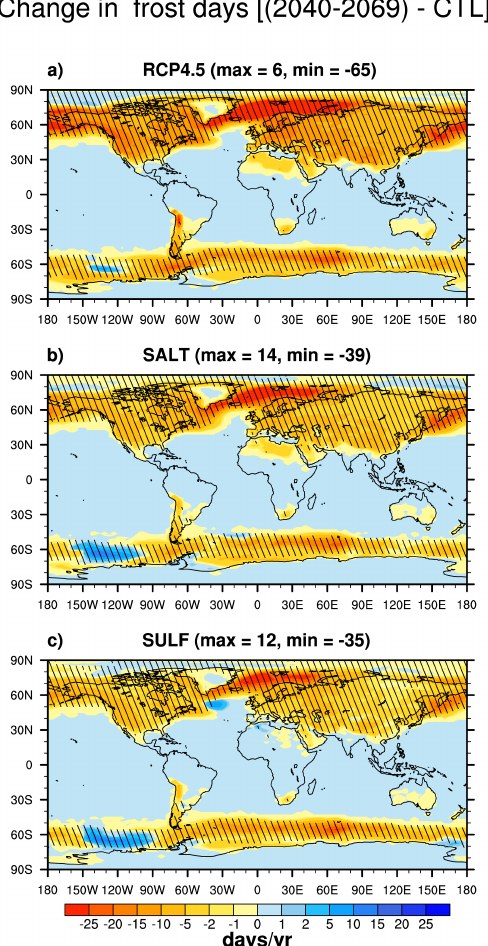
Figure 5. As Fig. 4, but for the mean change in frost days.